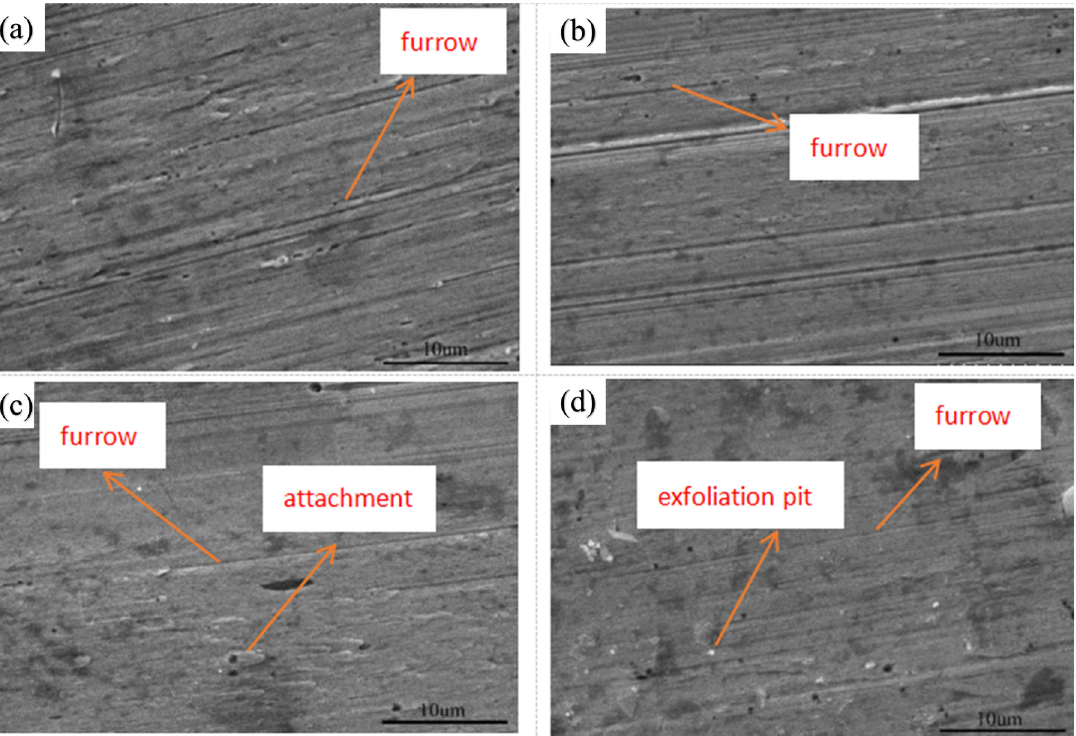
Figure 8. SEM images of worn areas of AlxFeCoCrNiMn cladding layer (a) x=0(b)x=0.5 (c) x=1.0 (d)